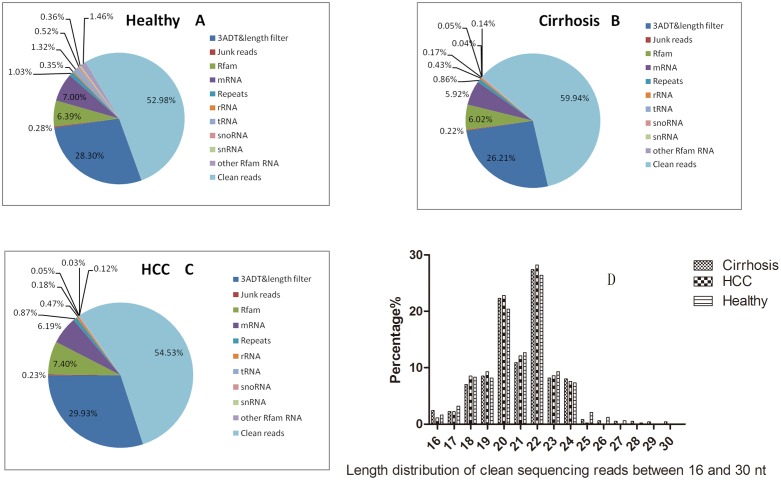
Sequenced reads and the distribution of reads.The Illumina Hiseq 2000 sequencing of the microRNAs obtained from the sera of patients in the control group, carrier group, and CHB group, produced 9,364,754,10,491,694, and 7,896,608 raw-reads, respectively, which, after extensive preprocessing and quality control, were reduced to 459,890,859,216, and 494,523 clean reads (Fig. 2A–C). All the distribution of reads of 16–30 nt length is presented in Fig. 2D.